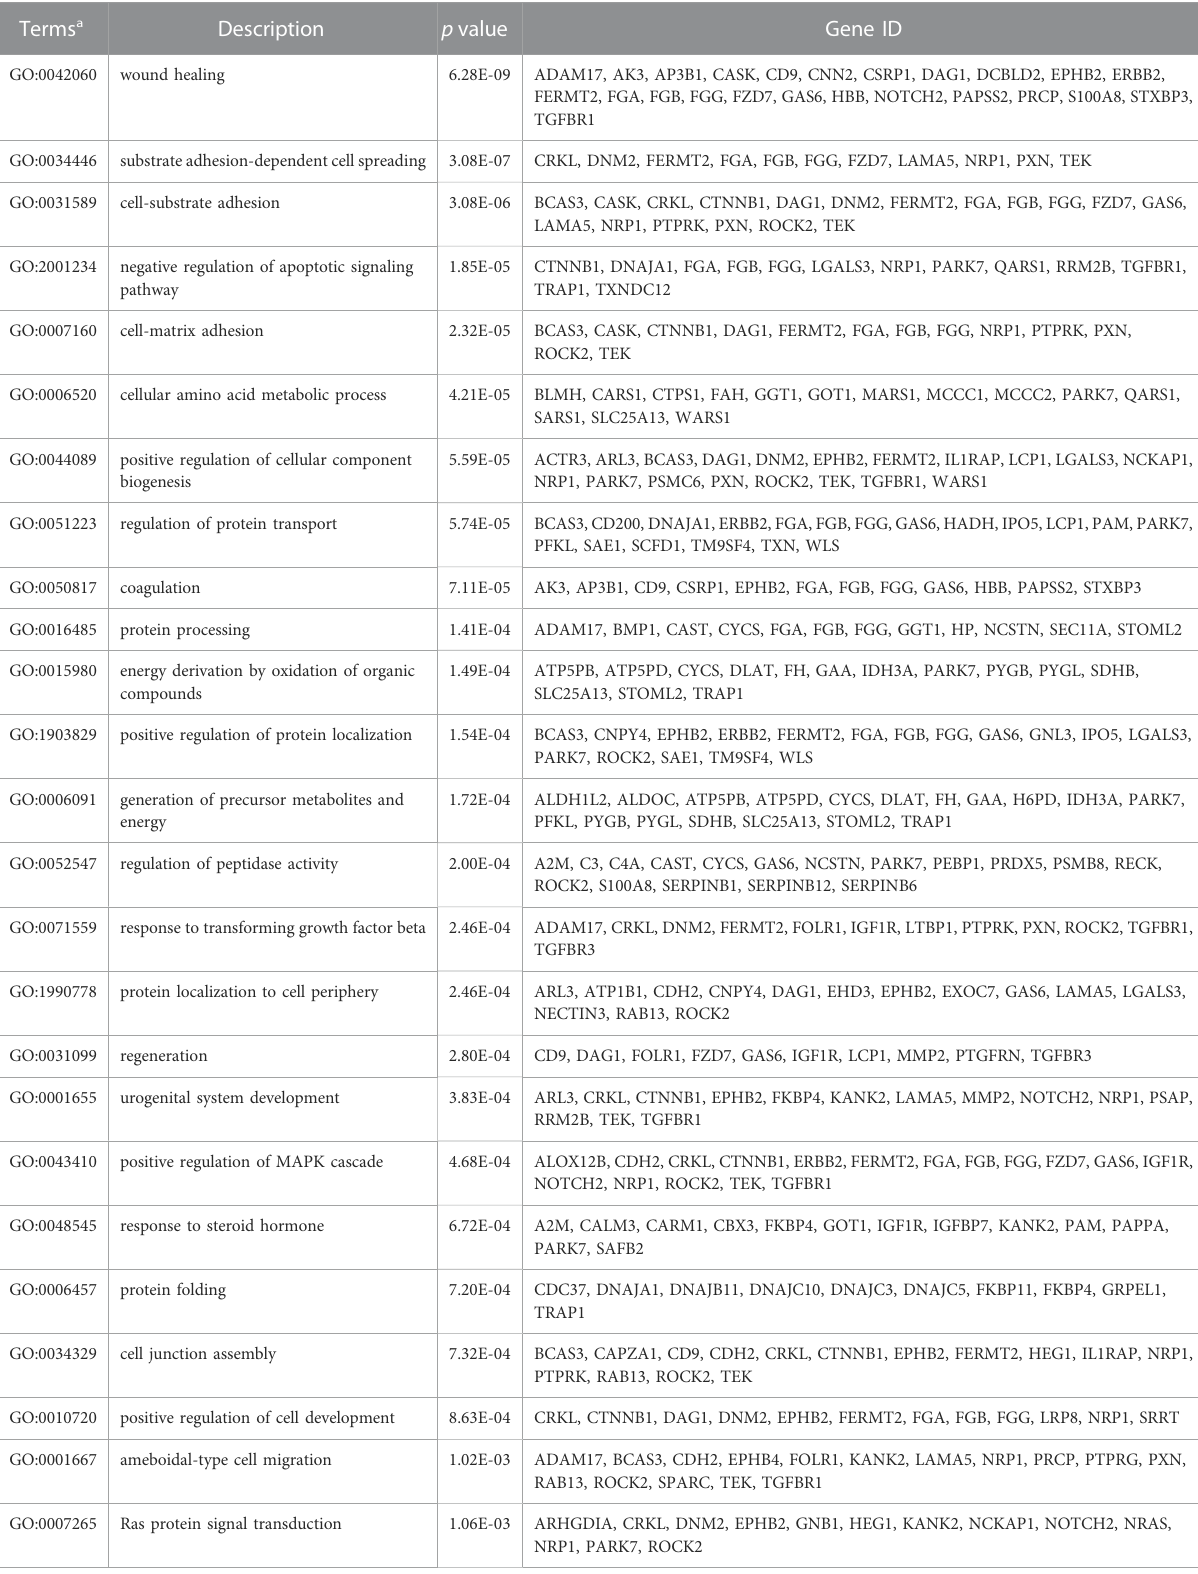
TABLE 2 Cell surfaceome analysis of EP-sEV treatment reveals key biological processes reprogrammed in human trophectoderm